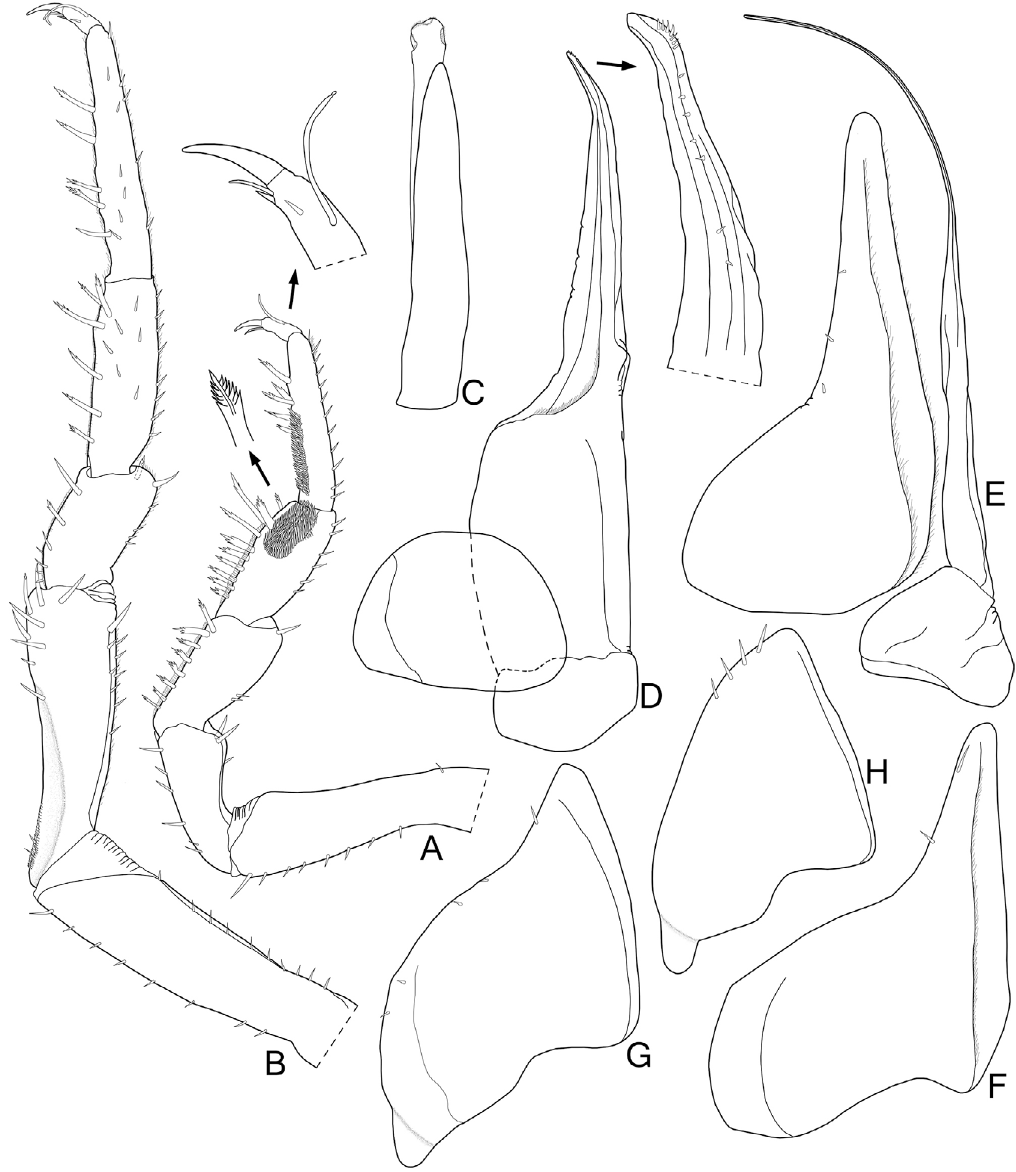
Figure 5. Caecopactes chullachaqui Campos-Filho, Sfenthourakis and Bichuette sp. nov., paratype. A , pereopod 1; B , pereopod 7; C , genital papilla; D , pleopod 1; E , pleopod 2; F , pleopod 3 exopod; G , pleopod 4 exopod; H , pleopod 5